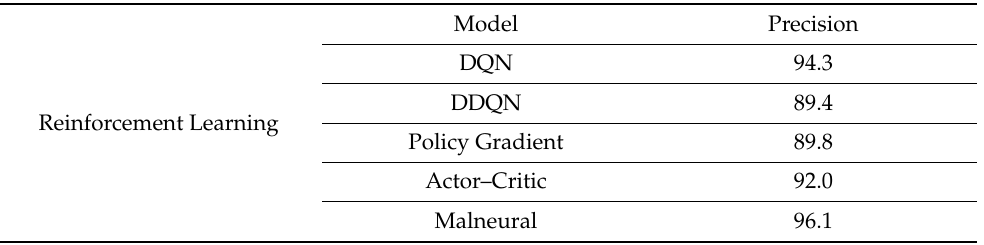
Table 11. Precision calculation for detection of monkeypox disease detection results using the einforcement learning approach.